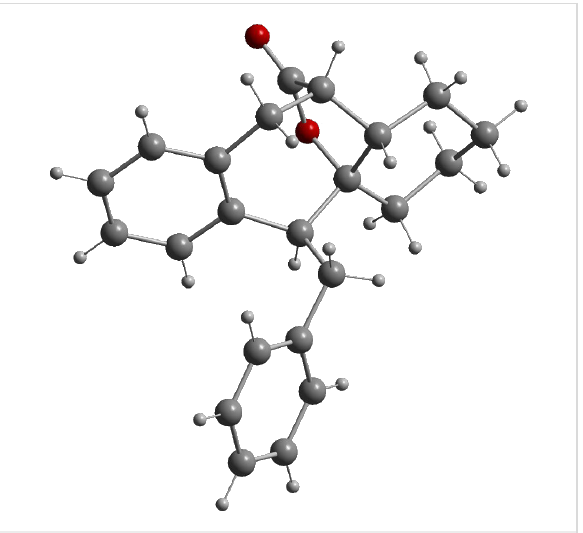
Figure 5: Molecular structure (Diamond [52]) of compound 40